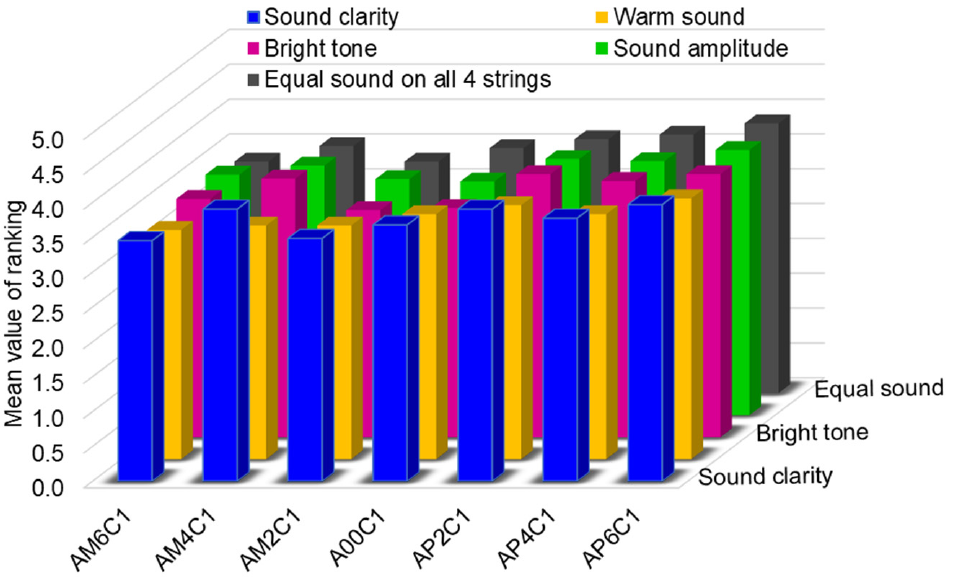
Figure 8. Variation of psycho-acoustic perception in the form of scores for the five investigated acoustic criteria.